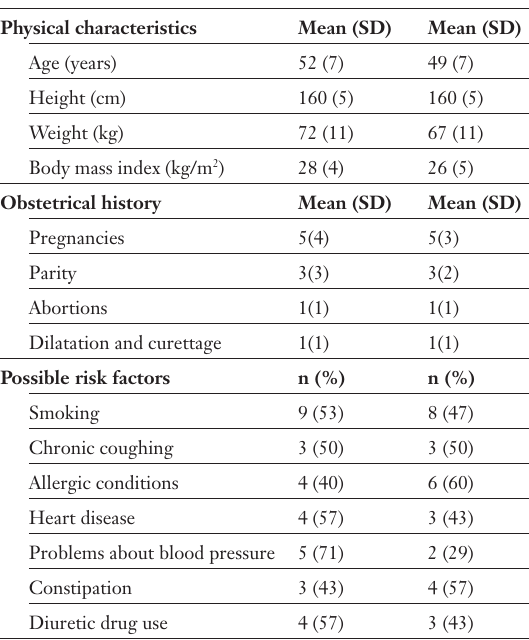
Physical characteris- tics and possible risk factors related to urinary incontinence of the